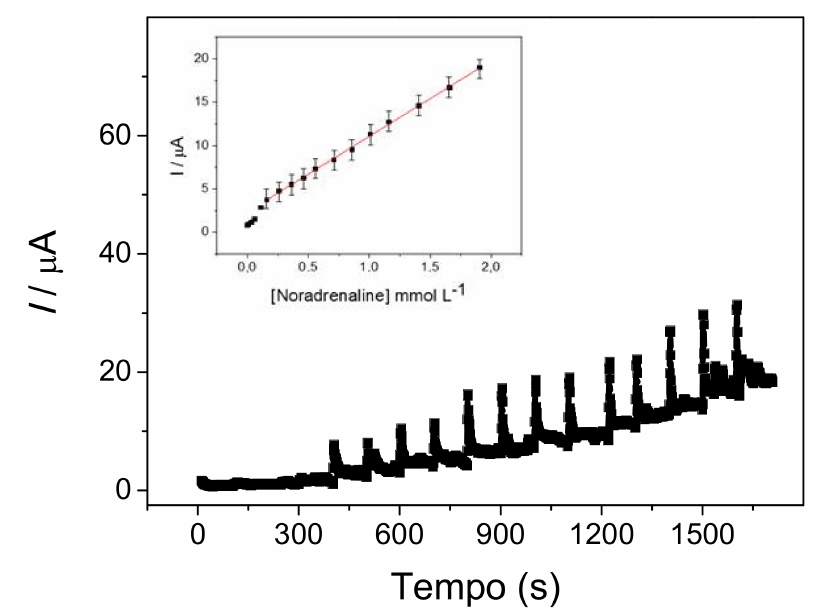
Figure 6. Calibration Curve based on the chronoamperometric response of a modified electrode with a GC/MWCNT/FCo 98 in PBS 0.1 mol L − 1 solution (pH 7.0) for 12 additions of 10 mmol L − 1 noradrenaline at a constant potential rate of 0.5 V vs.